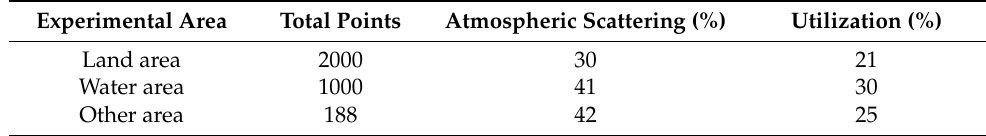
Table 13. Statistics of scattering correction results for the Xingkai Lake area using the MLP model. Experimental Area Total Points Atmospheric Scattering